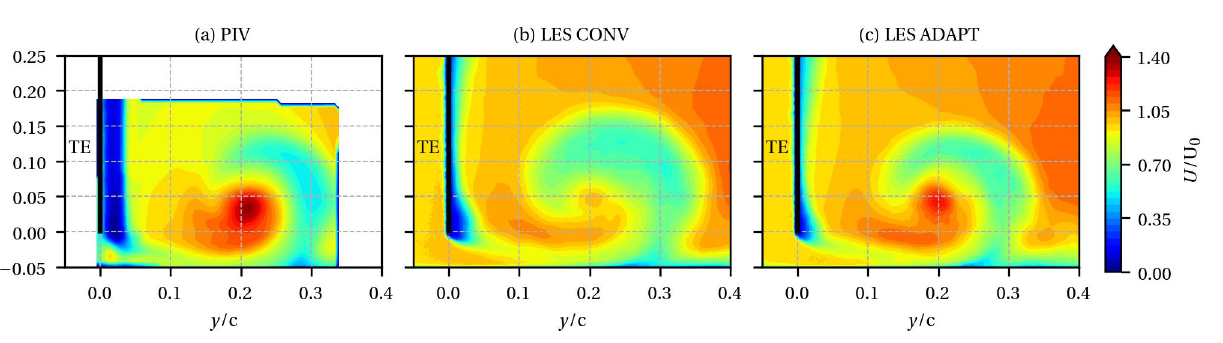
Figure 10. Mesh cuts at the airfoil leading edge at x /c = 0.01 before ( a ) and after ( b ) adaptation. Figure 11 compares the mean axial velocity U between PIV, LES CONV, and LES ADAPT of the tip leakage vortex at the airfoil trailing edge ( x /c = 0.01). With the proper mesh refinement, LES ADAPT is able to better retrieve the topology measured by the PIV. Indeed, the two velocity regions and even the position of the maximum of U are captured with less than 15% of the error as PIV.